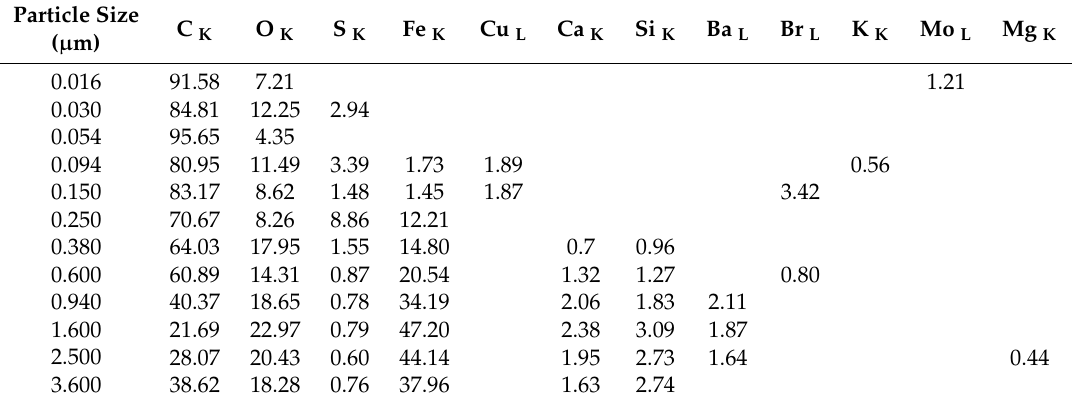
Table 4. Chemical composition of PM according to size at the M station (unit, %).